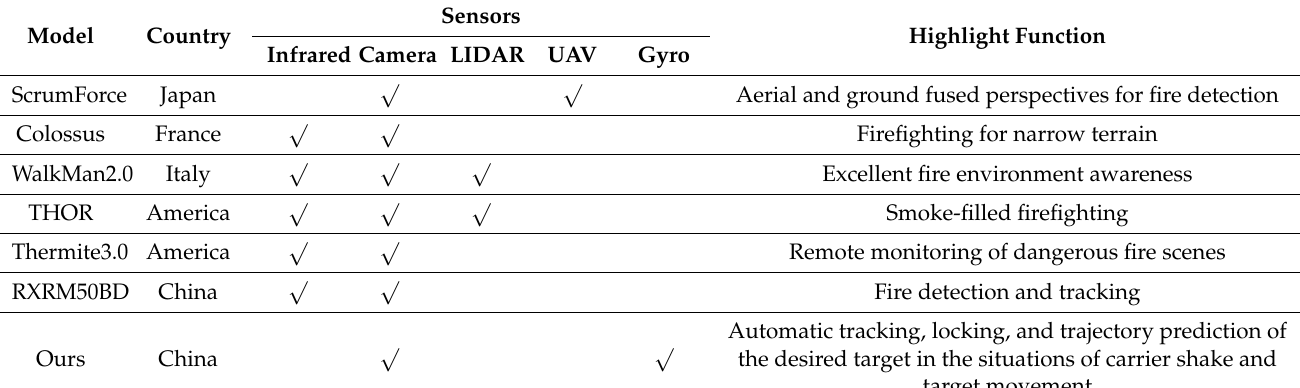
Table 1. Sensor parameters and highlights of the intelligent